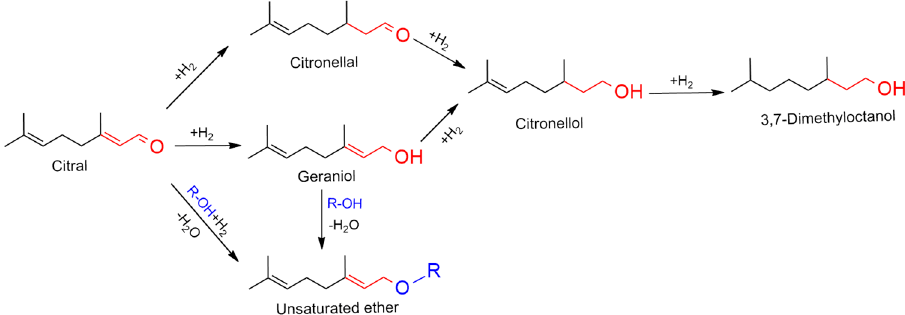
Figure 3. ( A ) Effect of H 2 pressure on UE yield. Reaction conditions: 1 mmol CA, 50 mg catalyst, 120 min, 373 K; ( B ) Influence of reaction temperature on UE yield. Reaction conditions: 1 mmol CA, 50 mg catalyst, 120 min, 0.1 MPa H 2 .